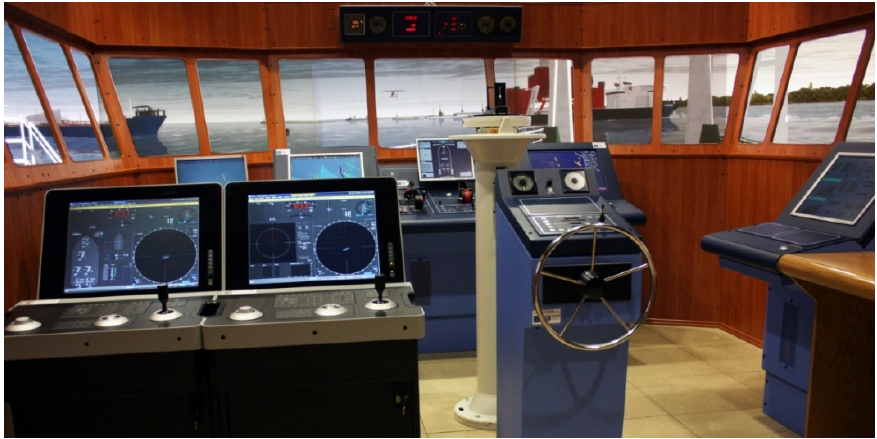
Figure 4. The FMBS used in the study.